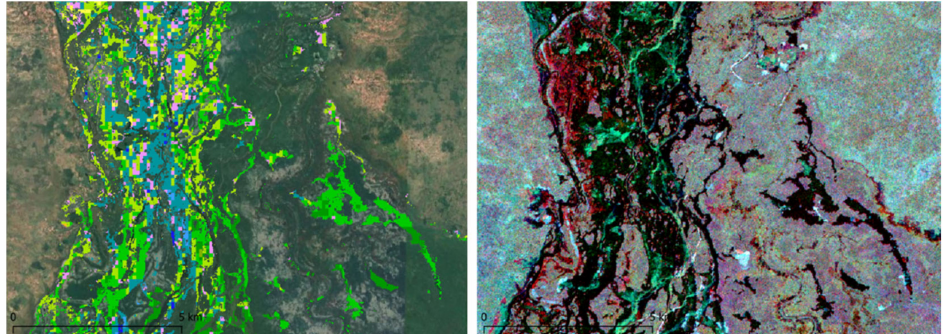
Figure 17. Detail area ( e ) in Figure 10. Left: pixels corresponding to cluster 8, colored according to the underlying CORINE class; background from Google Earth ™ imagery. Right: same area, extracted from the RGB change image in Figure